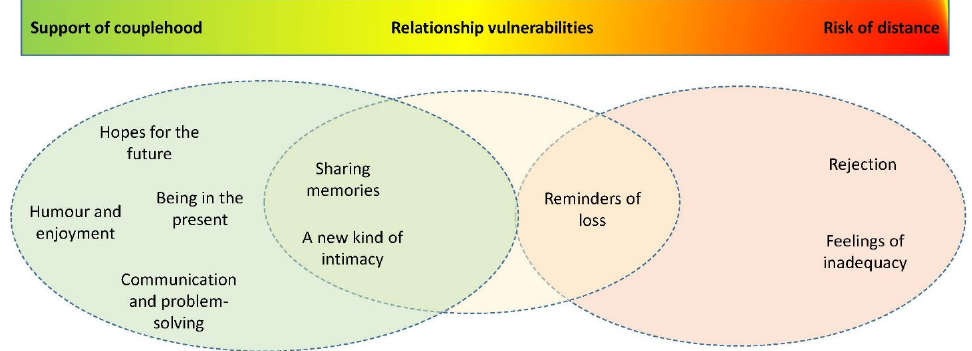
Figure 2. The influence of caregiver-delivered music therapy interventions on the caregiver-PwD relationship: quality themes and overarching themes.